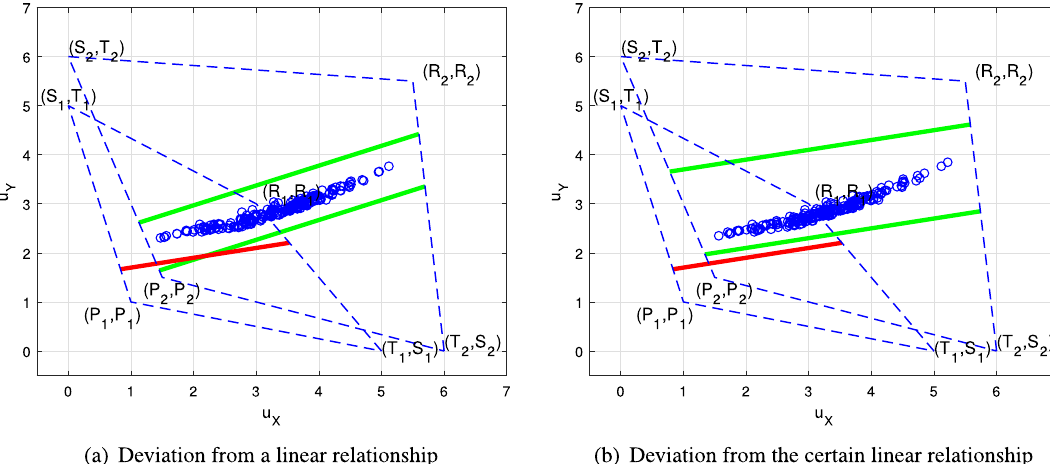
Figure 3. The relation between bounds of Theorems 2 and 3 and players’ utilities in G 2 . Consider ω 1 = [ T 1 , R 1 , P 1 , S 1 ] = [ 5, 3, 1, 0 ] and ω 2 = [ T 2 , R 2 , P 2 , S 2 ] = [ 6, 11 2 , 3 2 , 0 ] . Choose + β S ω 1 + γ 1 + p 0 , where (α , β , γ) = ( 1 p = α S ω 1 X Y lines describe the relationship between players’ utilities in G 1 . The green lines describe the bounds according to Theorems 2 and 3. Then we randomly generate 200 player Y ’s strategies, and the blue circles are ( u